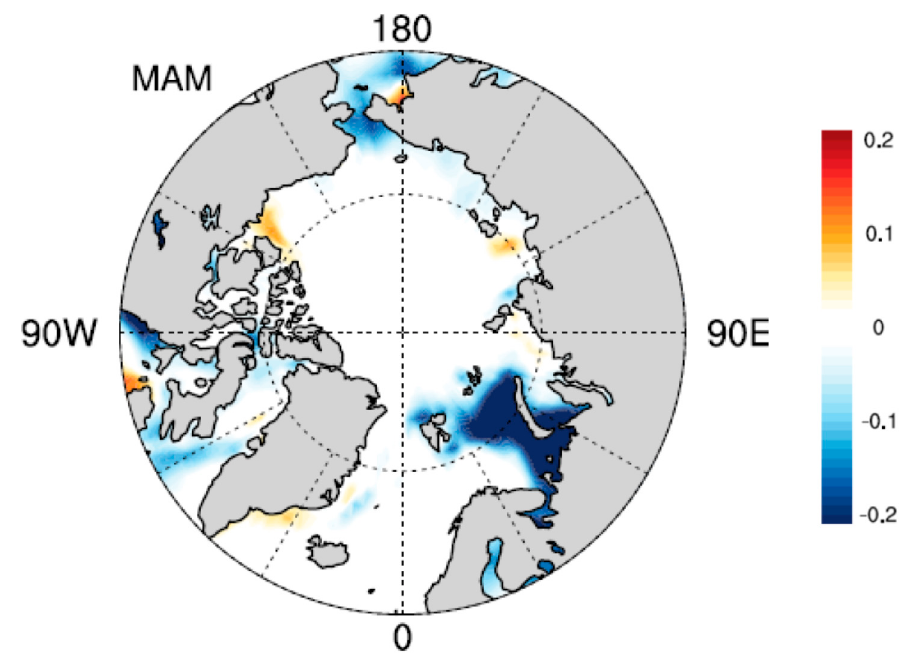
Figure 4. Spatial distribution of Neg—Pos differences in Arctic sea-ice fraction for MAM.